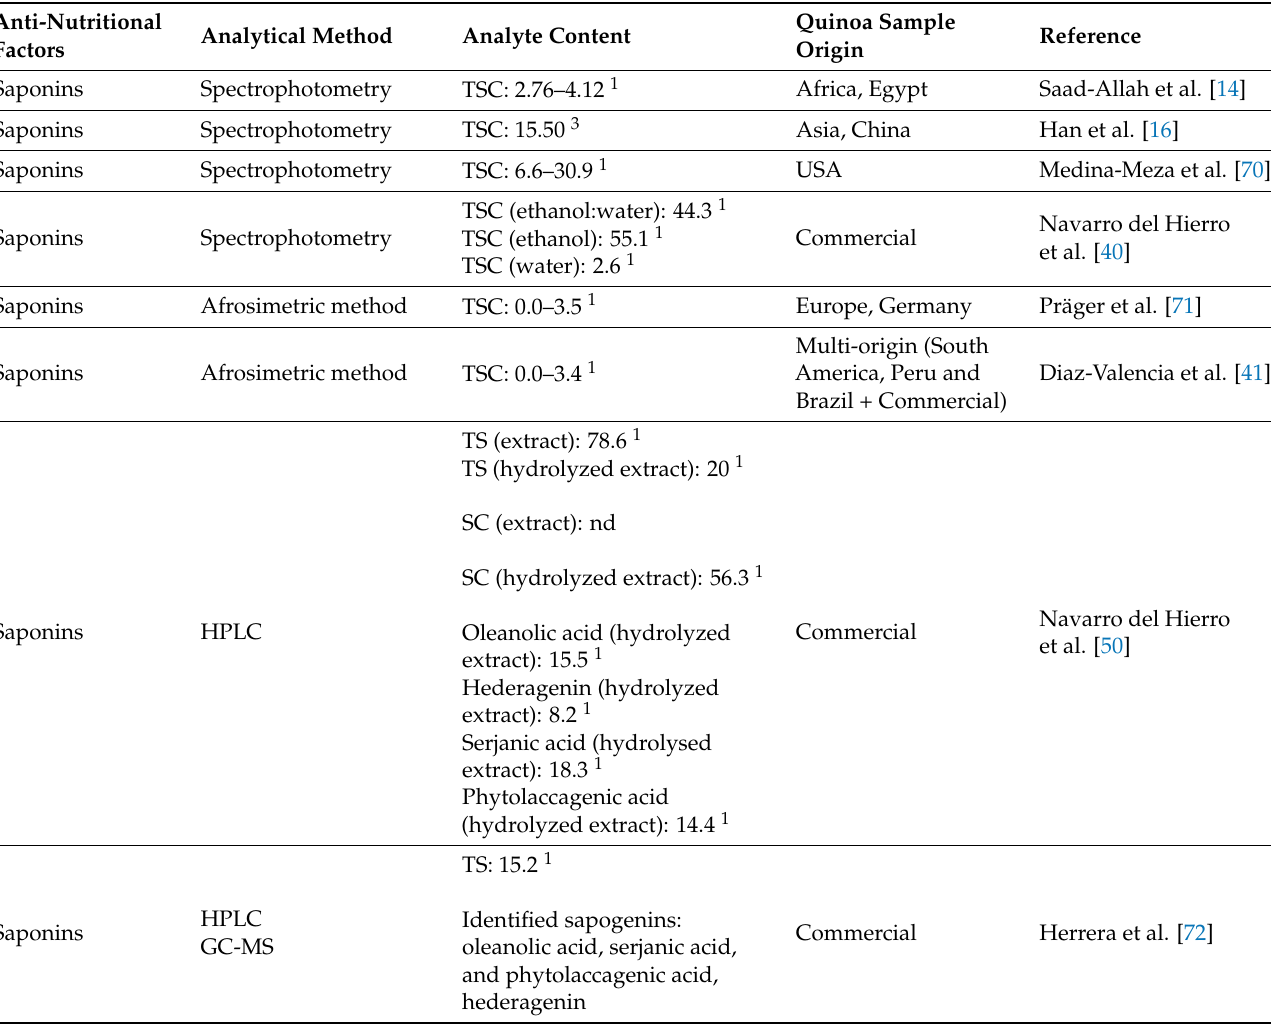
Table 6. Anti-nutritional factors in quinoa